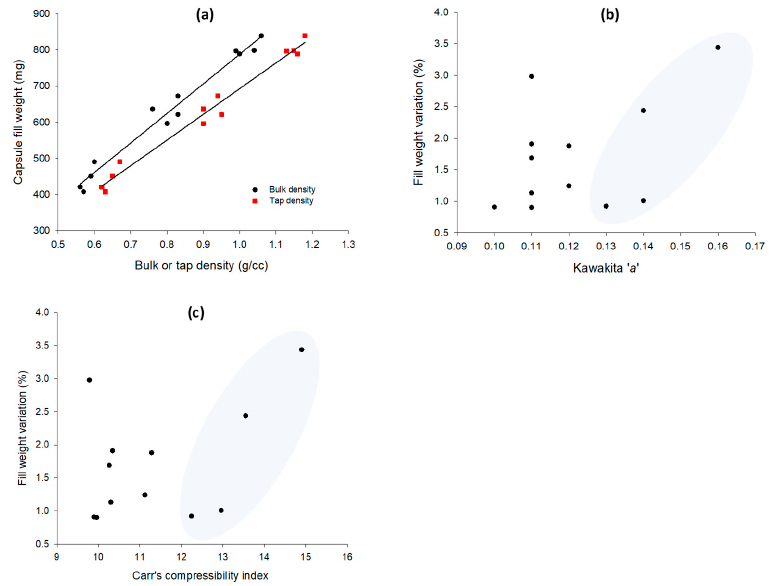
Figure 5. Capsule fill weight vs. bulk or tap density ( a ), fill weight variation vs. Kawakita’s a ( b ), and Carr’s compressibility index ( c